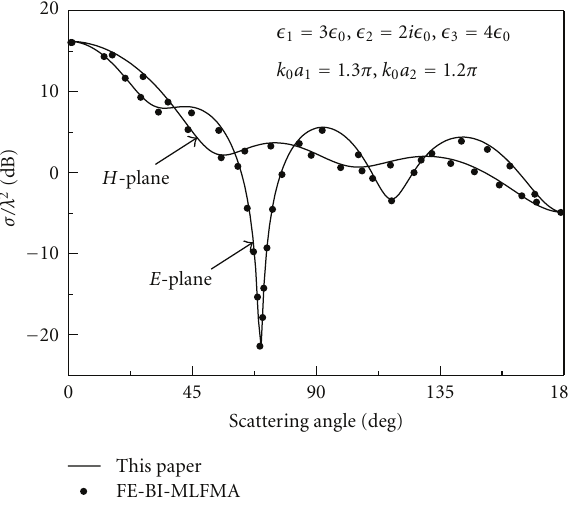
Figure 2: Radar cross-sections (RCSs) versus scattering angle θ (in degrees): results of this paper (solid curve) and FE-BI-MLFMA method. The electric dimensions of the outer and inner spherical surfaces are chosen as k 0 a 1 = 1 . 3 π and k 0 a 2 = 1 . 2 π while the per- mittivity tensor elements of the plasma are assumed to be (cid:2) 1 = 3 (cid:2) 0 , (cid:2) = 2 i (cid:2) (cid:2) = 4 (cid:2) 2 0 , and 3 0 , respectively.